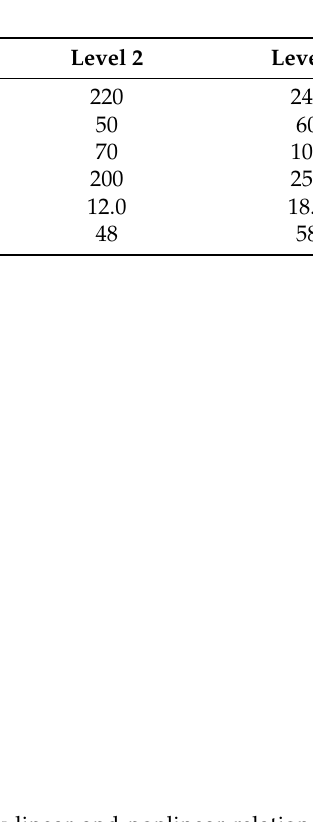
Figure 2. Results of the preliminary experiment to show linear and nonlinear relation between packing time and mass. Table 5. Injection molding conditions of linear relation group.